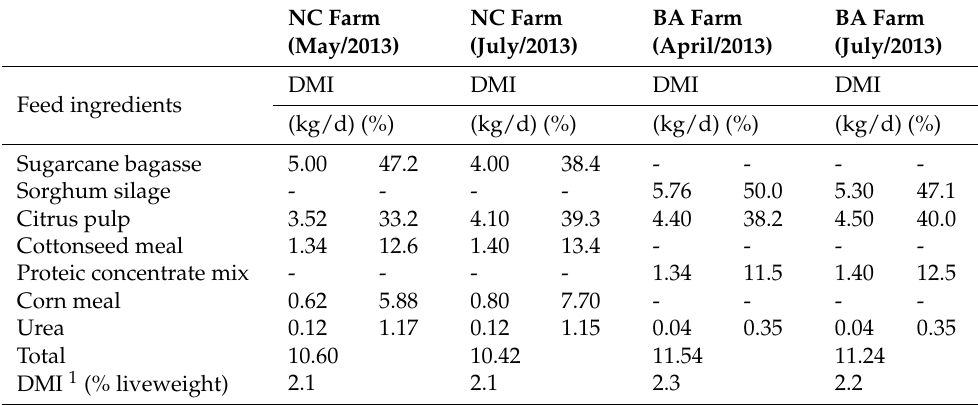
Table 3. Diets of the two feedlots for sire production. Values for a 500 kg